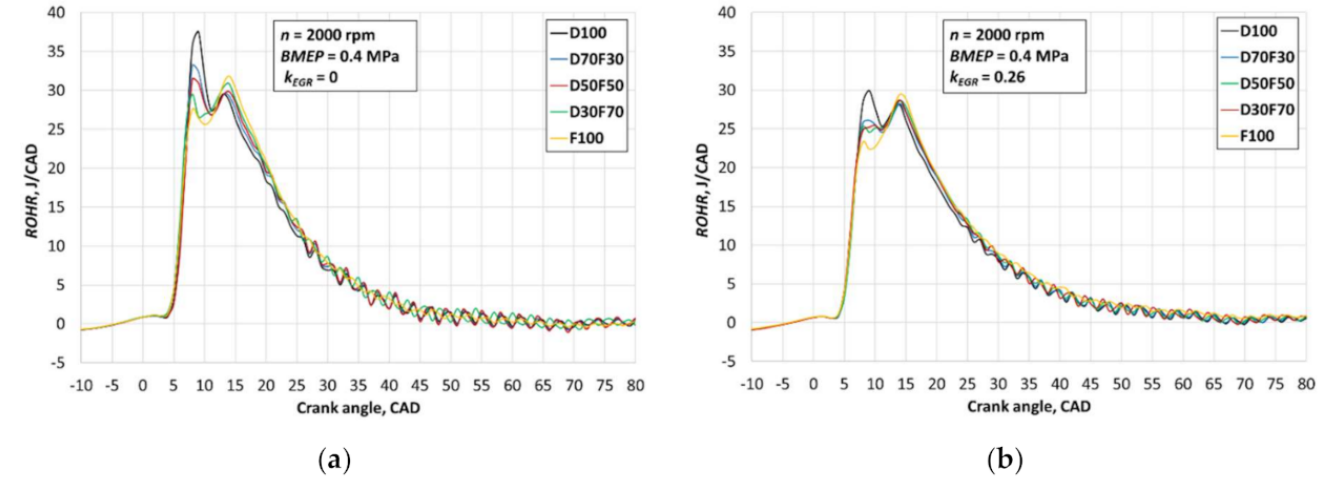
Figure 2. The in-cylinder rate of heat release depending on fuel composition with ( a ) exhaust gas recirculation (EGR) off and ( b ) EGR